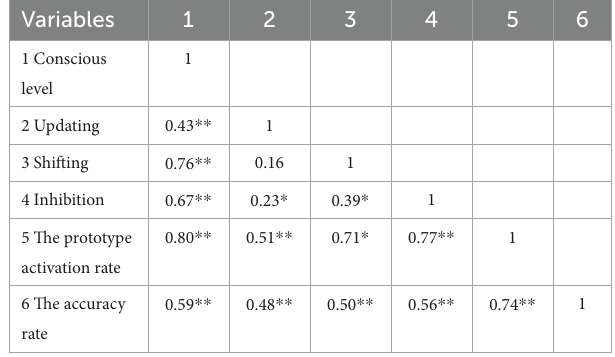
TABLE 4 Correlation analysis between variables (the total EF score has been deleted).